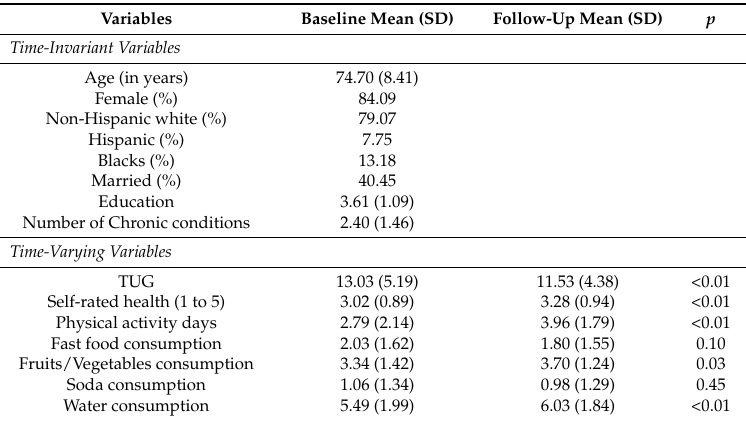
Table 1. Descriptive statistics: baseline and